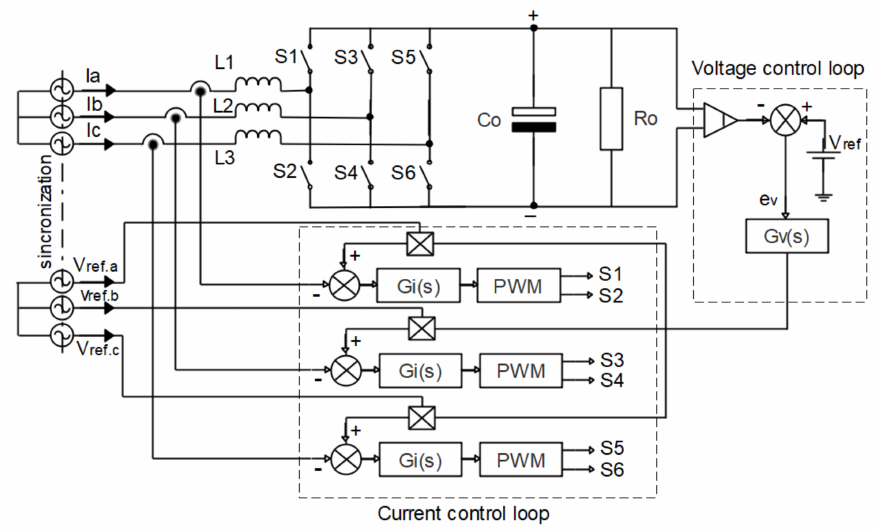
Figure 9. BOOST-type PWM rectifier with PFC and respective control